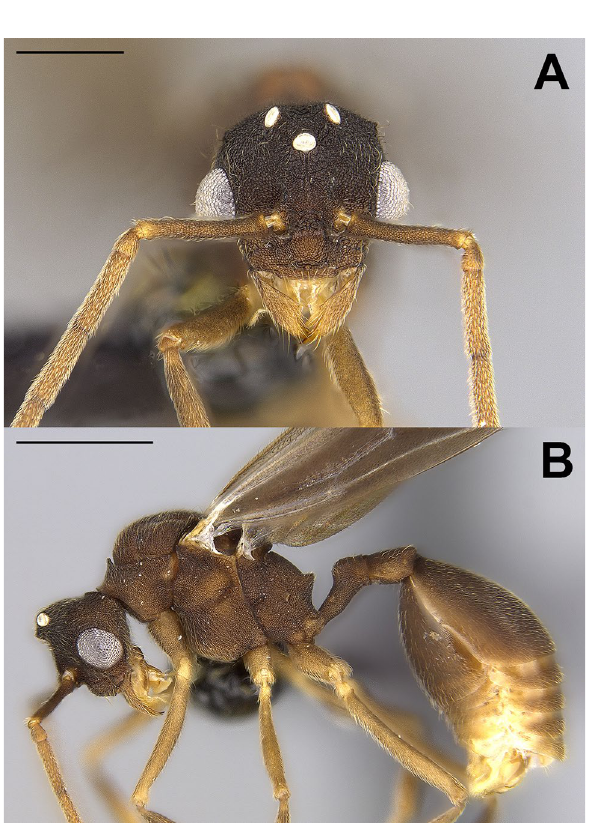
Figure 10. Males of the fungus-growing ant Mycocepurus smithii in full-face ( a ) and lateral ( b ) views. The scale bars represent 0.5 mm in ( a ) and 1 mm in ( b ). Male individuals were collected from a sexually reproducing colony in Belém, Pará in